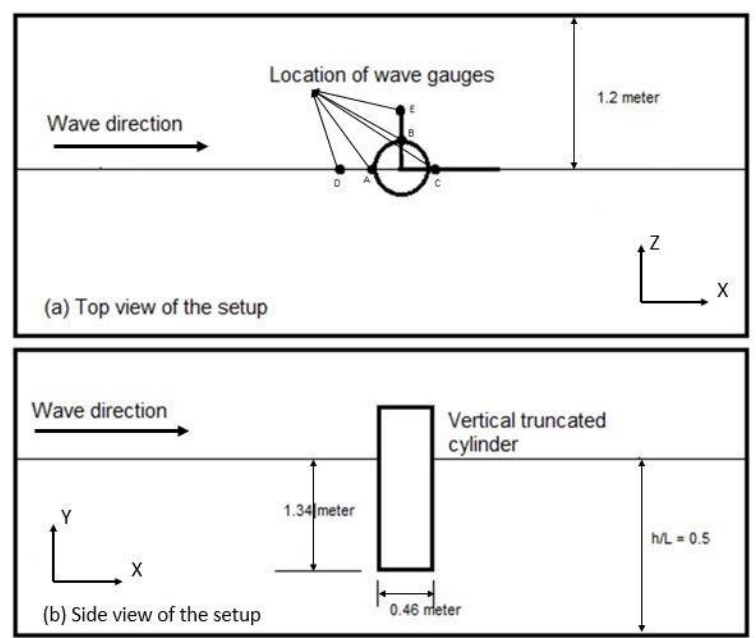
Figure 3. Schematic diagram of the simulation case setup, ( a ) top view and ( b ) side view of the setup.